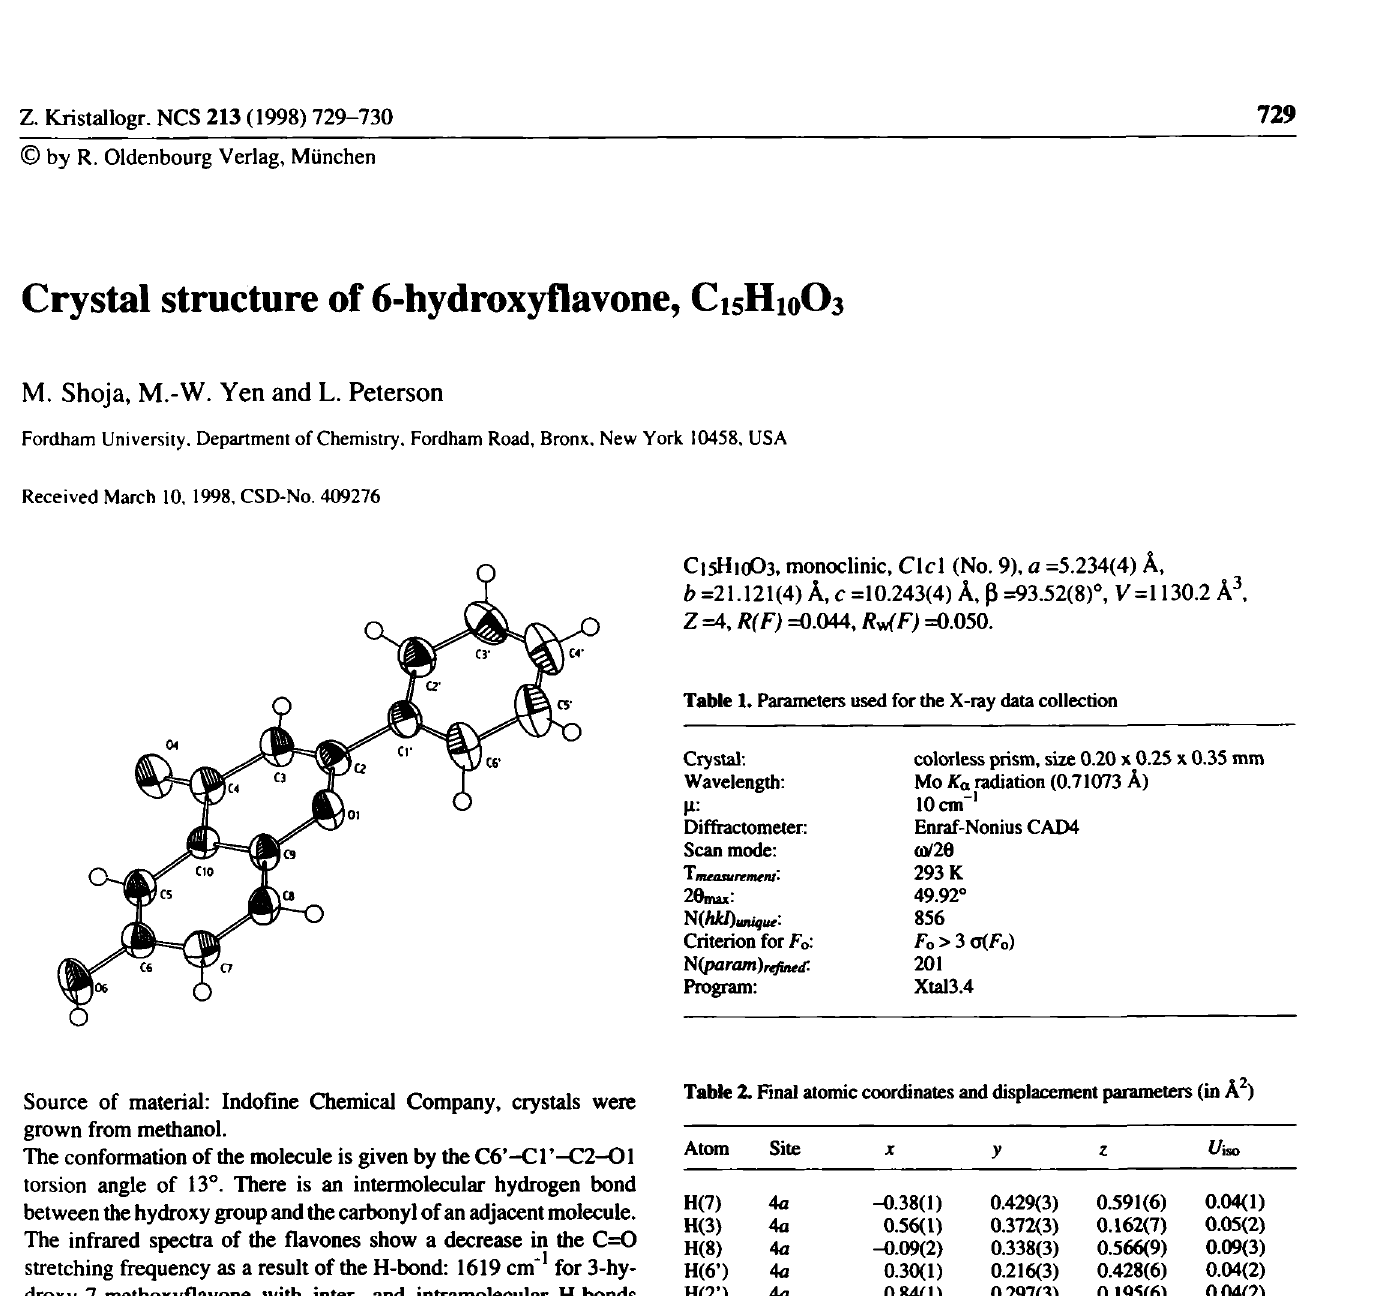
Table 2. Final atomic coordinates and displacement parameters (in